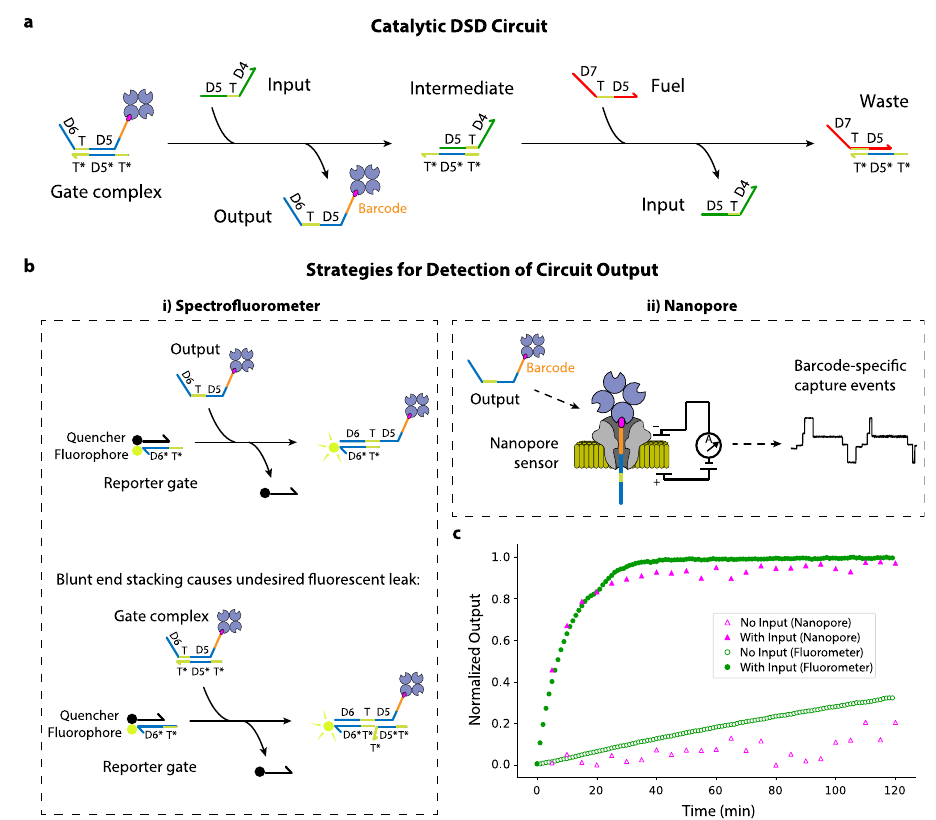
Fig. 2 | Nanopore and fl uorometer-based comparison of catalytic DSD circuit kinetics. a Diagram of a seesaw catalytic DSD circuit. Single-stranded input dis- places the 3 ’ labeled biotin-streptavidin single-stranded output from the gate complex, forming an intermediate with the bottom strand. The displaced output strand is now free to capture in a nanopore. Single-stranded fuel displaces input from the intermediate, recycling the input. b Displaced output ssDNA can be read out using two detection strategies: (i) Spectro fl uorometer-based detection . Output strand displaces the quencher-labeled strand from a fl uorophore-labeled reporter